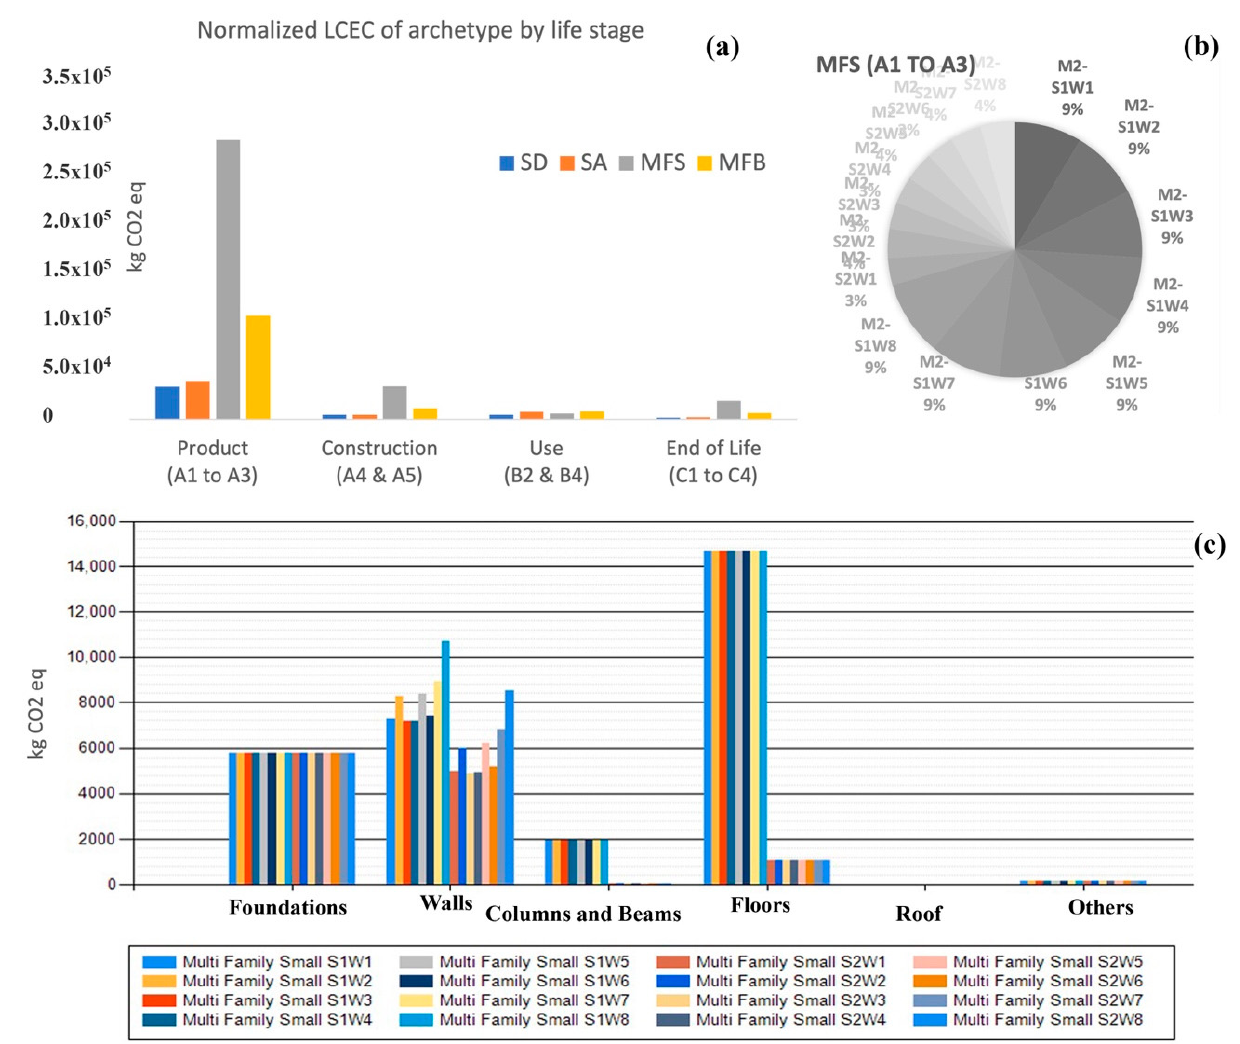
Figure 5. LCEC of the existing building stock: ( a ) LCEC per life cycle stage, ( b ) LCEC per archetype, and ( c ) LCEC per building assembly.